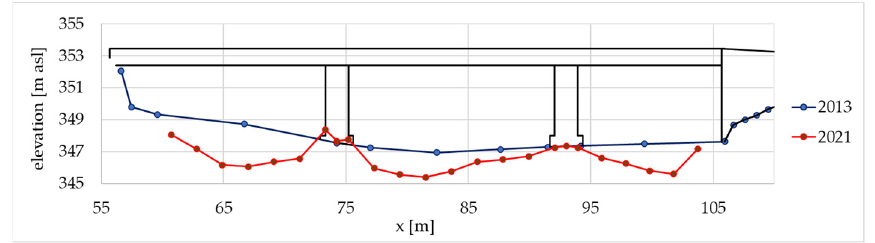
Figure 6. Riverbed elevation comparison between 2013 and 2021 at the bridge cross-section.